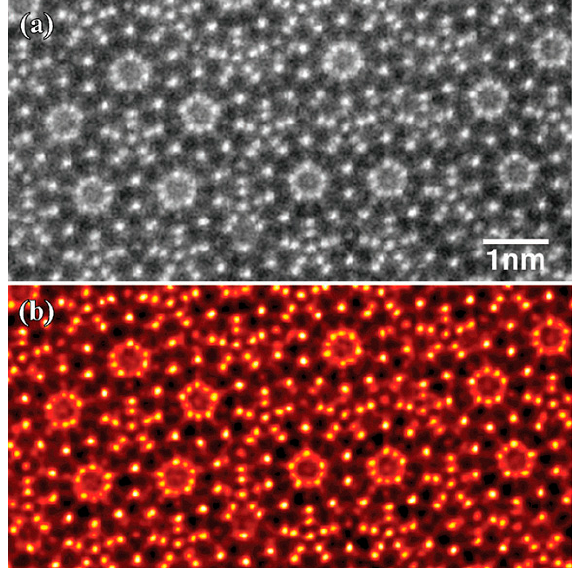
Figure 8. Ultrahigh-resolution HAADF-STEM images of decagonal Al 64 Cu 22 Co 14 taken along the periodic axis: ( a ) original image; and ( b ) image after maximum-entropy deconvolution (reproduced from reference [46] with permission).